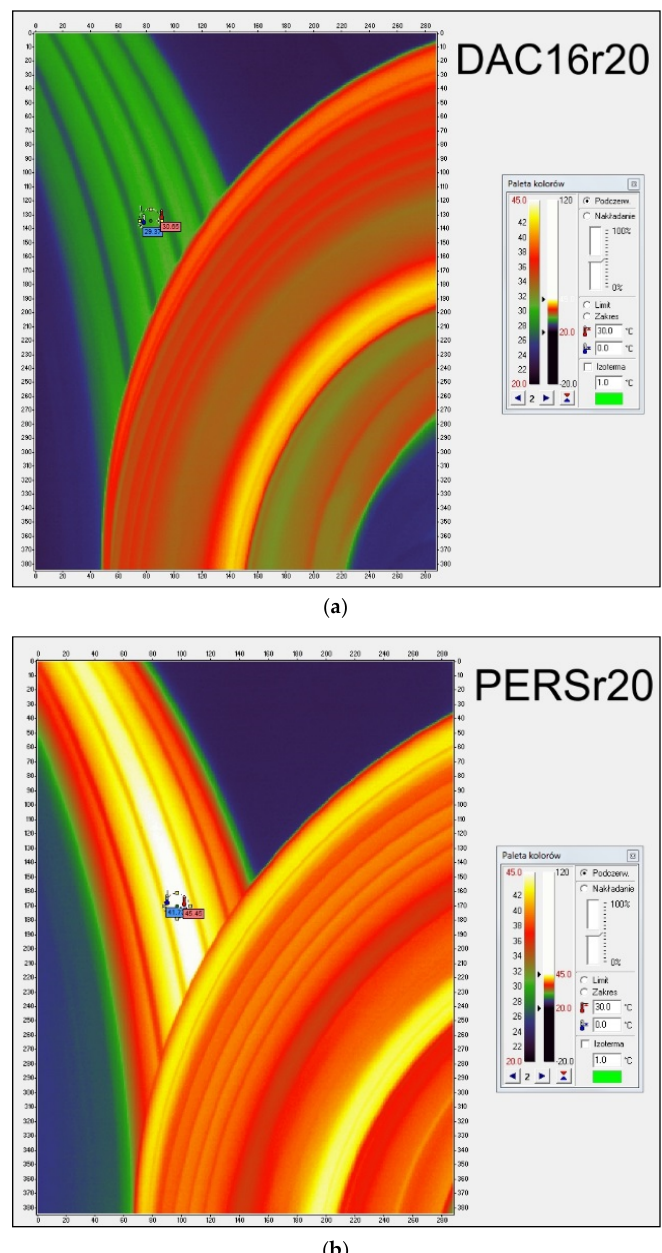
Figure 10. ( a )Thermographic image of truck tire rolling on DAC16r20; and ( b ) PERSr20. Figure 10. ( a ) Thermographic image of truck tire rolling on DAC16r20; and ( b )